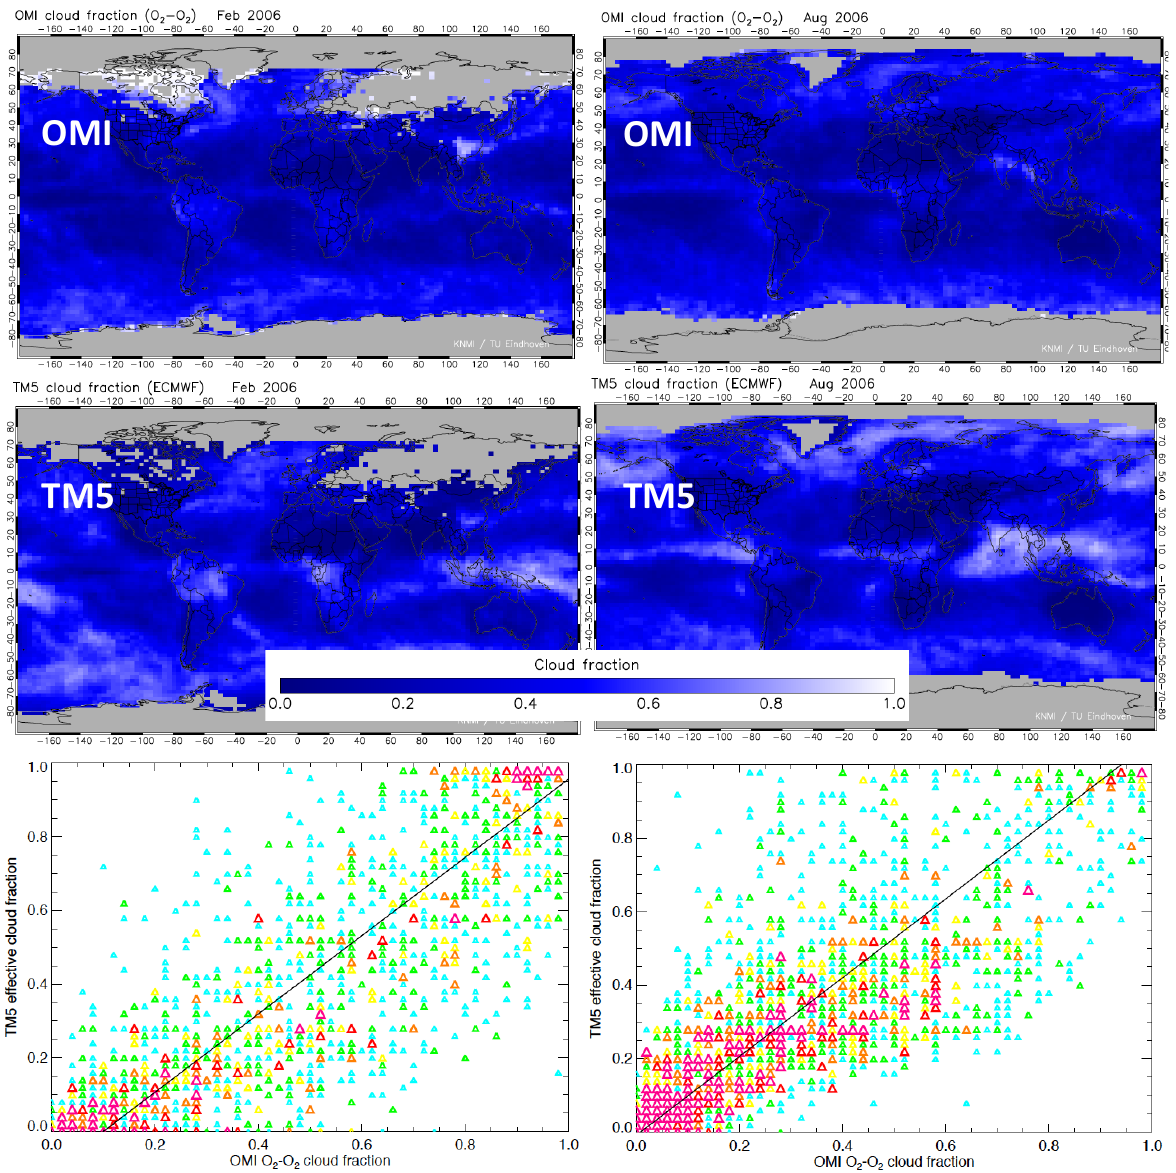
Figure 2. Monthly average effective cloud fraction observed from OMI (upper panels) and simulated by TM5 based on ECMWF meteo- rological fields (middle panels) in February (left column) and August 2006 (right). Cloud fractions have been selected only for those days and locations that had a successful OMI O 2 –O 2 retrieval. Grey areas indicate less than three successful coincidences. Bottom panels: scatter plot of daily pairs of OMI ( x axis) and TM5 cloud fractions ( y axis) in February 2006 (left) and August 2006 (right) over Europe (10 ◦ W– 30 ◦ E; 35–60 ◦ N). The colours indicate the number of times a particular grid cell has been filled, where light blue corresponds to 2 × , green 3 × , yellow 4 × , orange 5 × , red 6 × , and magenta to 7 × or more. TM5 effective cloud fractions can be expressed as − 0.10 + 1.06 f OMI (February) and − 0.01 + 1.07 f OMI